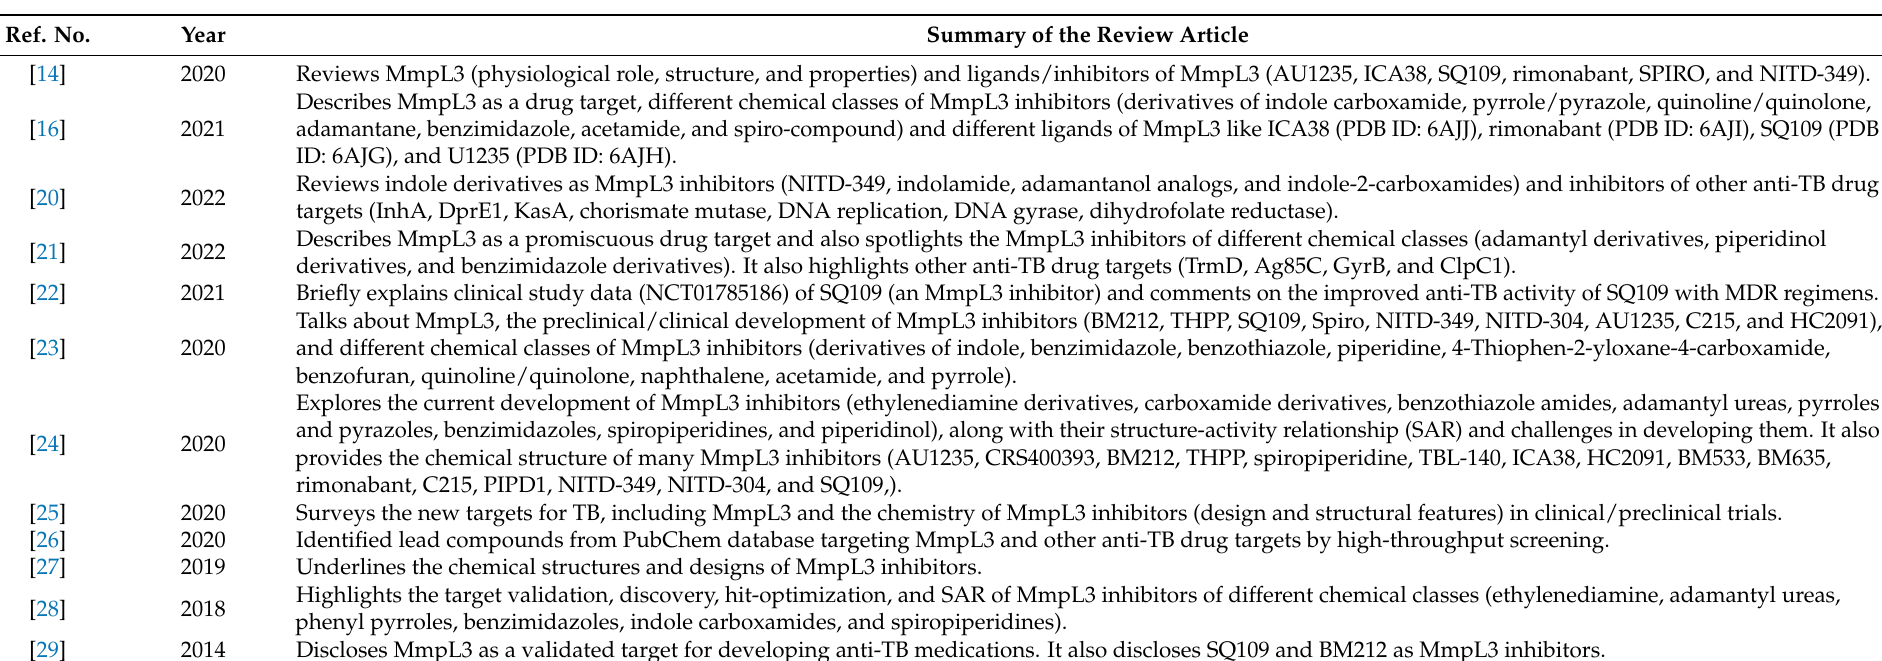
Table 1. Summary of relevant and recent review articles on MmpL3. Ref.